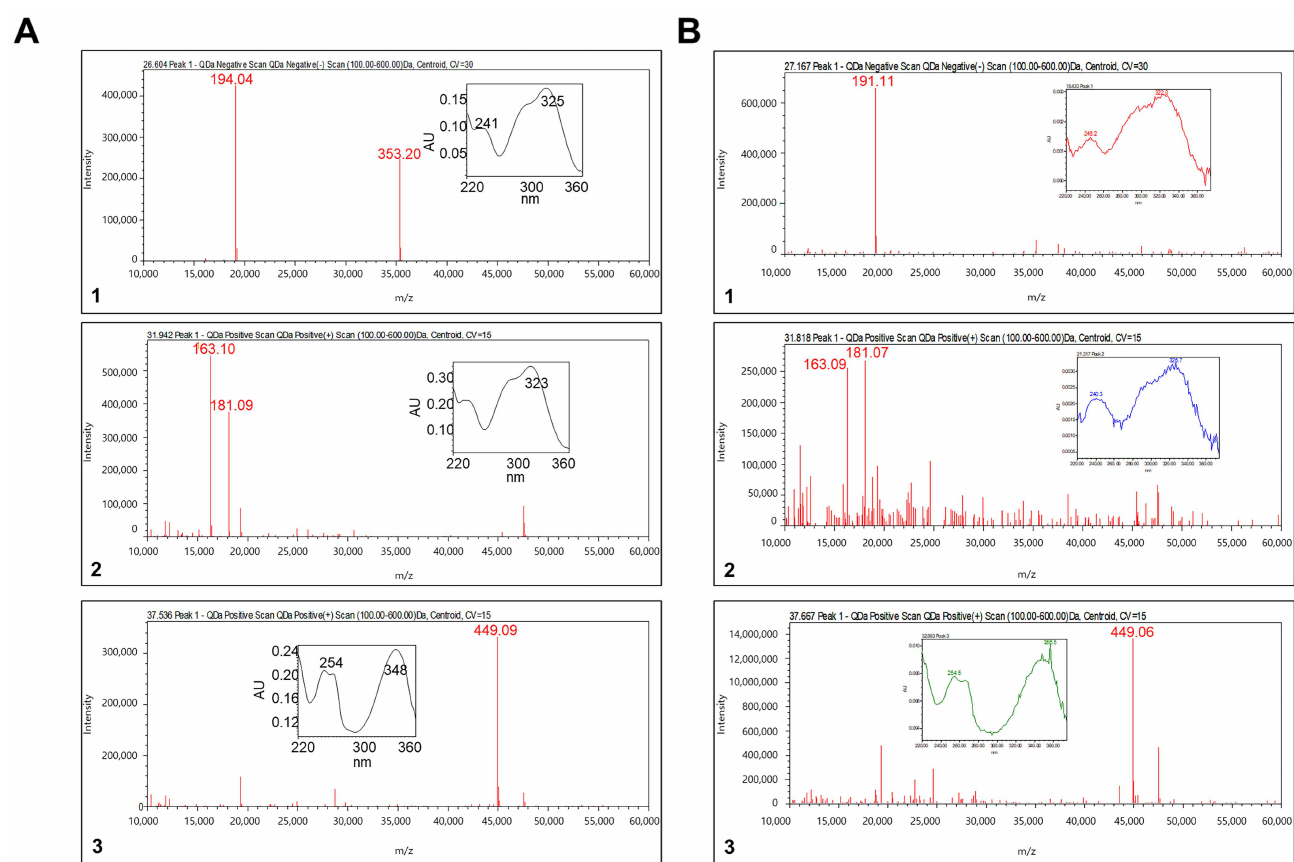
Figure 1. Representative LC-MS result: ( A ) standard solution and ( B ) TH sample. ( 1 ) Chlorogenic acid, ( 2 ) caffeic acid, and ( 3 ) luteolin